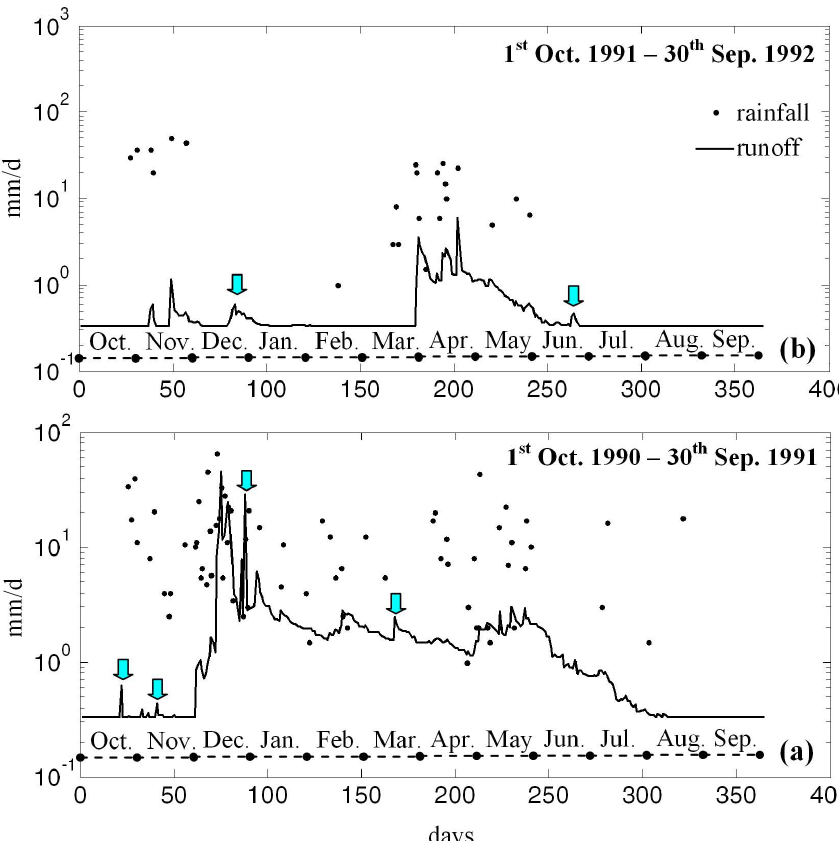
Fig. 1. Measured precipitation depths and daily river discharges per unit area of the basin at the location of the hydroelectric plant (HP, point A in Fig. 2) for the period 1 October 1990–30 September 1992. Vertical arrows indicate abrupt changes of the river discharge in the absence of